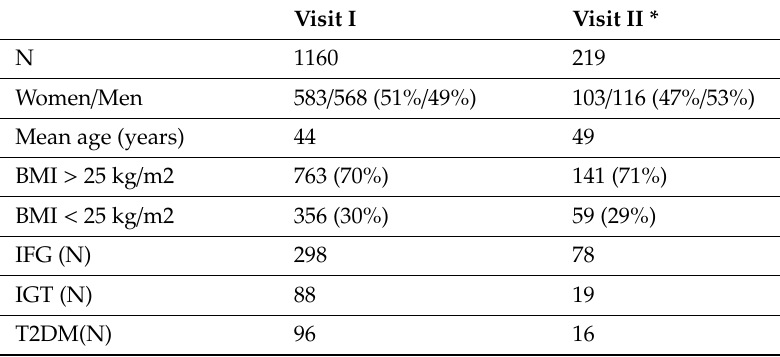
Table 1. Characteristics of the studied population.